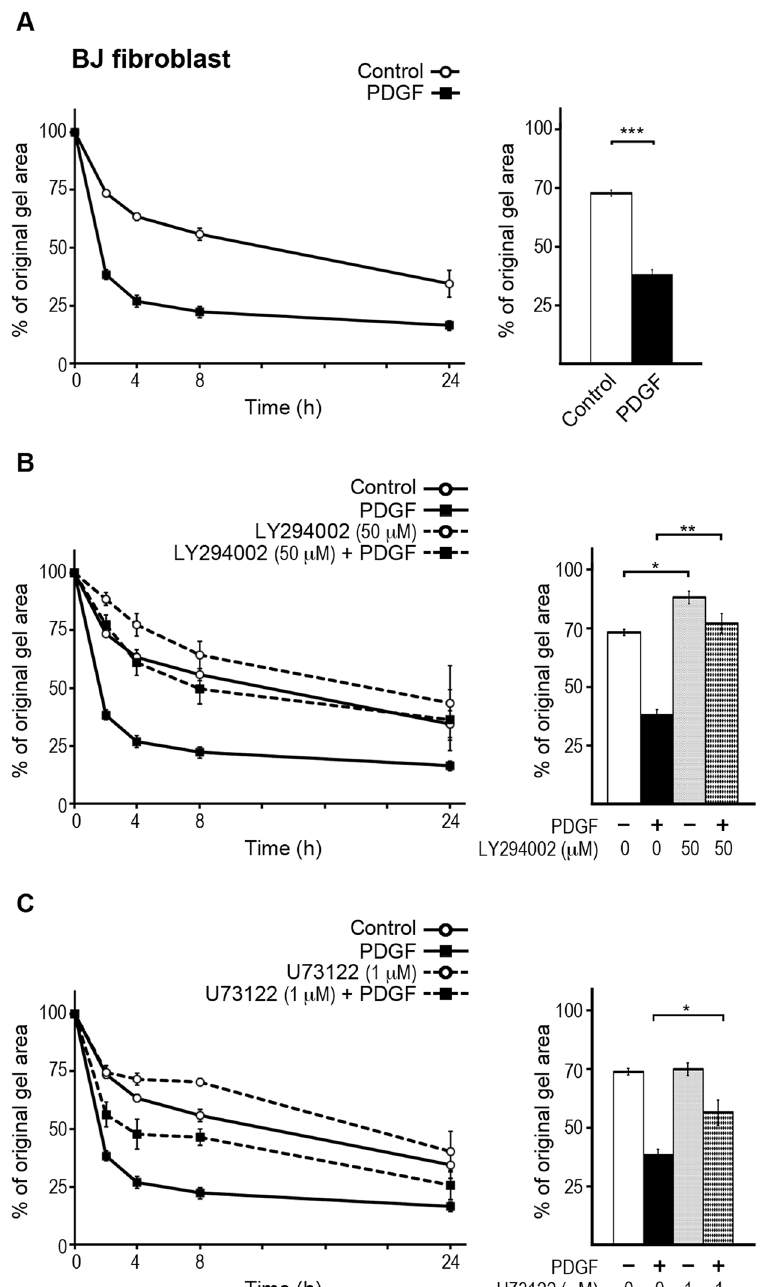
Figure 1. PI3K or PLC γ inhibition reduces PDGF-enhanced collagen gel contraction. ( A ) Collagen gel contraction by BJ fibroblasts were studied in presence or absence of 20 ng/mL PDGF-BB. The line graph (Left) presents the dynamic of contraction during 24 h, and bar chart (Right) presents the contraction after 2 h to illustrate the early effect of PDGF-BB on contraction. ( B , C ) BJ fibroblast cells were treated with the PI3K inhibitor LY294002 ( B ) or the PLC γ inhibitor U73122 ( C ) and contraction proceeded in presence or absence of 20 ng/mL PDGF-BB. In all panels, values represent average of at least four independent experiments. ( * ) indicates p < 0.05, ( ** ) indicates p < 0.01, and ( *** ) indicates p < 0.001. Error bars are